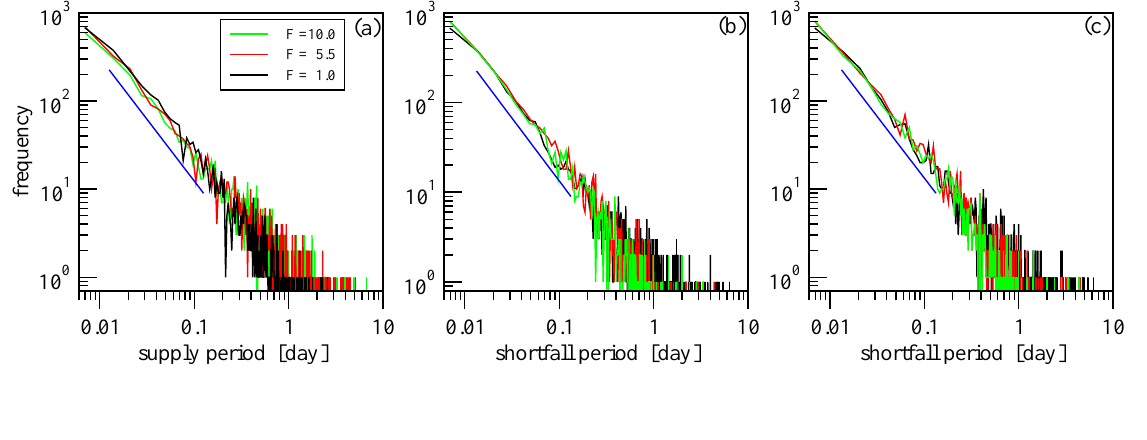
Figure 10. The same as Figure 9, for the aggregated wind power record P